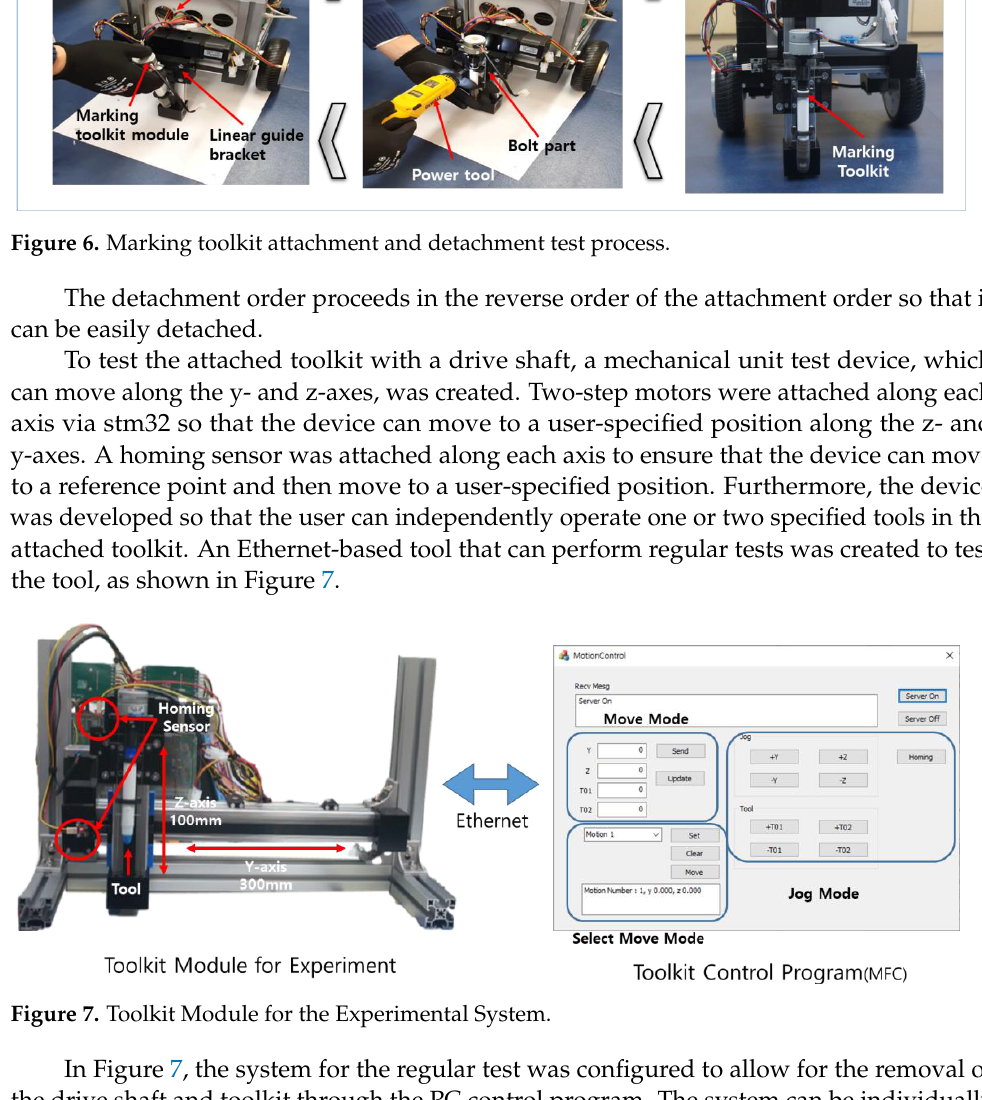
Figure 6. Marking toolkit attachment and detachment test process .